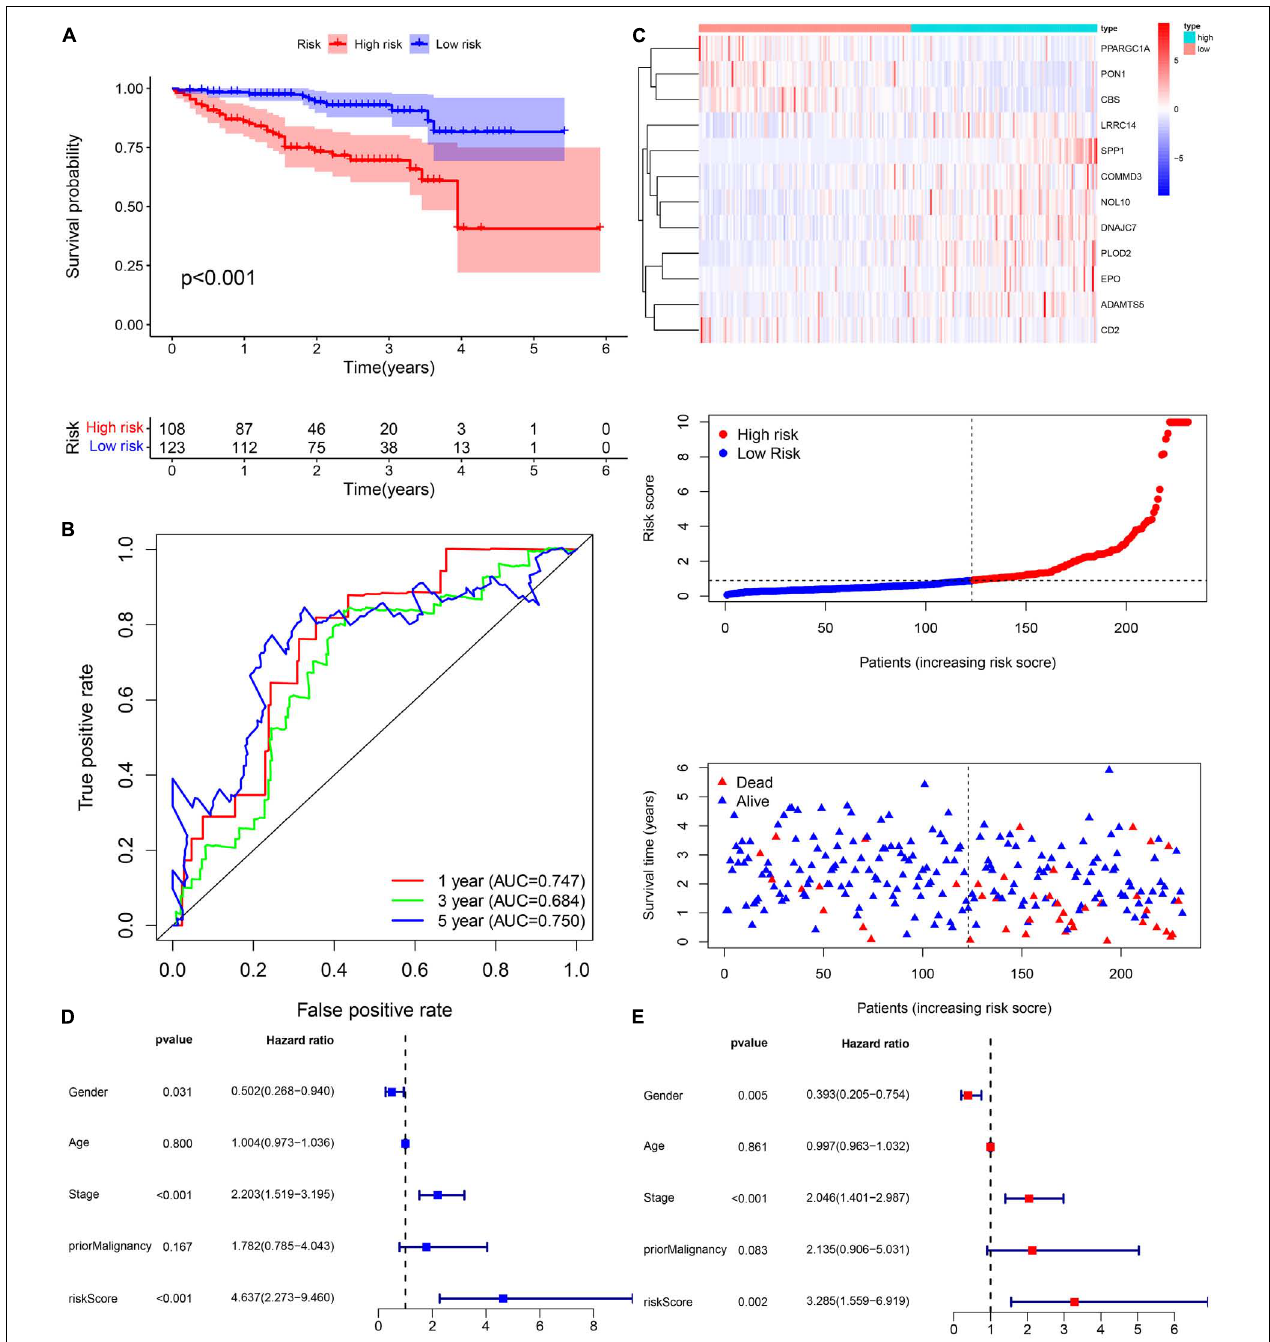
FIGURE 12 | External validation of the risk score in the ICGC cohort. (A,B) The Kaplan–Meier survival analysis and the time-dependent ROC analysis for the risk score in predicting the OS of patients in the ICGC cohort. (C) The heatmap, risk score distribution, and survival status of patients in the ICGC cohort. (D) The forest plot of univariate Cox analysis. (E) The forest plot of multivariate Cox